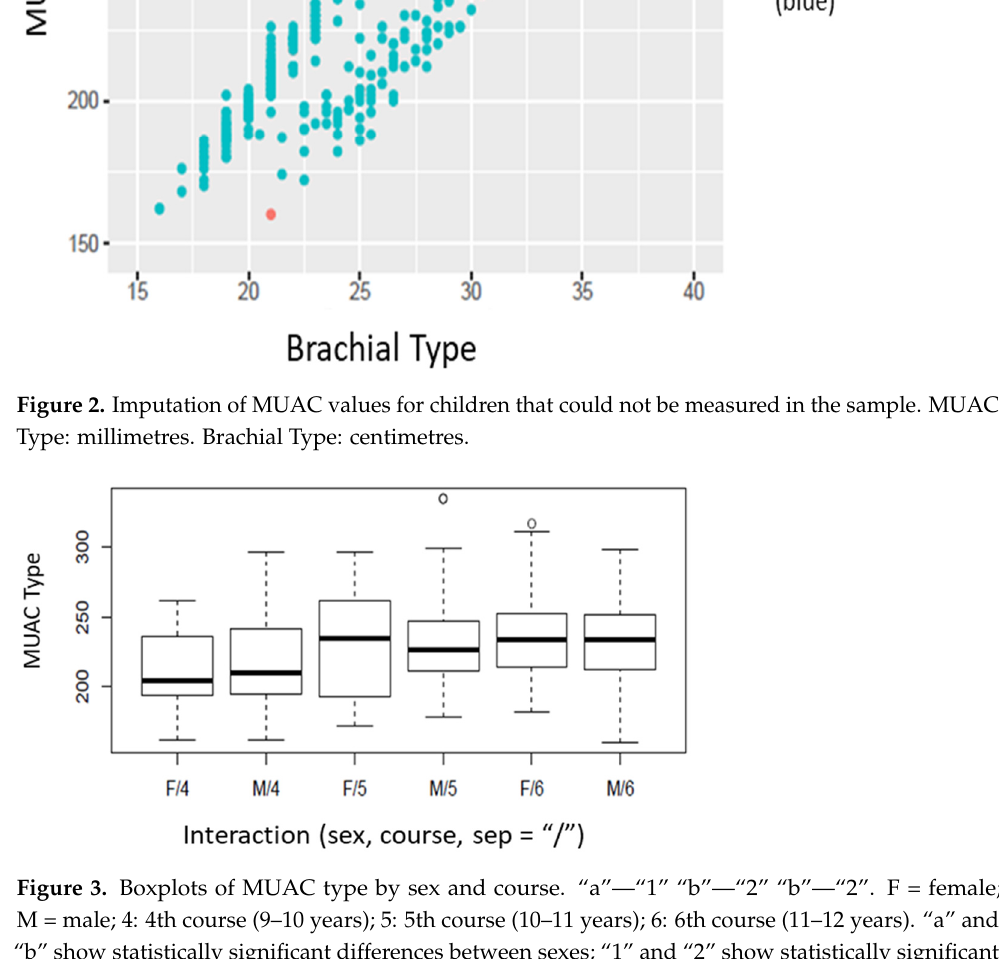
Figure 2. Imputation of MUAC values for children that could not be measured in the sample. MUAC Type: millimetres. Brachial Type: centimetres.